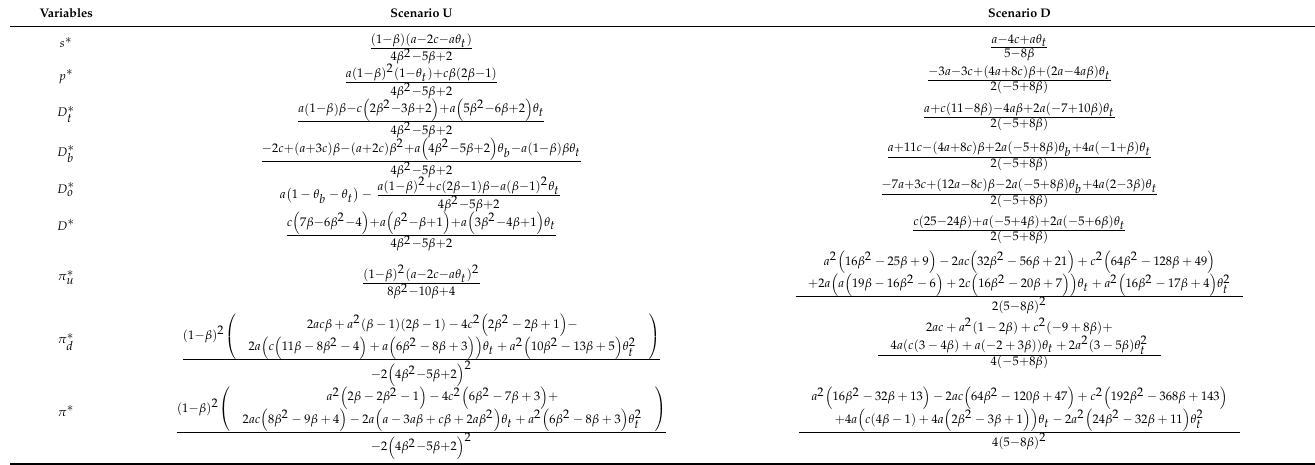
Table 2. The optimal strategies for Scenario U and Scenario